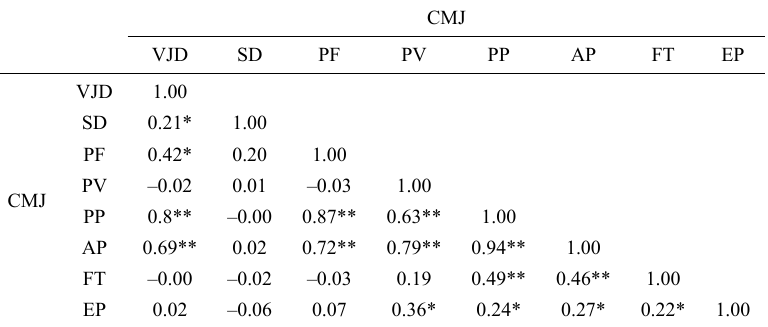
Table 4. Results of intercorrelation of variables during CMJ tests (n = 96).